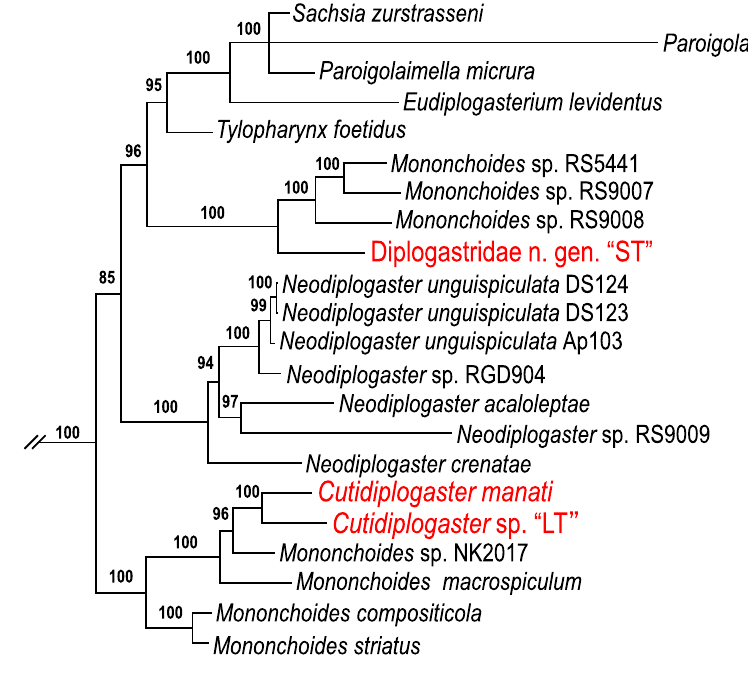
Figure 2. The phylogenetic status of three manatee-associated nematodes among closely-related species. The combined Bayesian tree was inferred from near full length of SSU and D2-D3 LSU under GTR + G + I model applied for both loci. The parameters are as follows: lnL = − 24,768.25718; freqA = 0.25; freqC = 0.21; freqG = 0.27; freqT = 0.27; R(a) = 1.00; R(b) = 2.88; R(c) = 2.38; R(d) = 0.88; R(e) = 4.25; R(f) = 1.00; Pinva = 0.38; Shape = 0.57) for SSU, and lnL = − 27,032.96896; freqA = 0.21; freqC = 0.22; freqG = 0.32; freqT = 0.25; R(a) = 0.43; R(b) = 1.50; R(c) = 0.79; R(d) = 0.36; R(e) = 3.07; R(f) = 1.00; Pinva = 0.20; Shape = 1.03). Posterior probability values exceeding 50% are given on appropriate clades. The full phylogenetic tree is provided in Supplementary Fig.